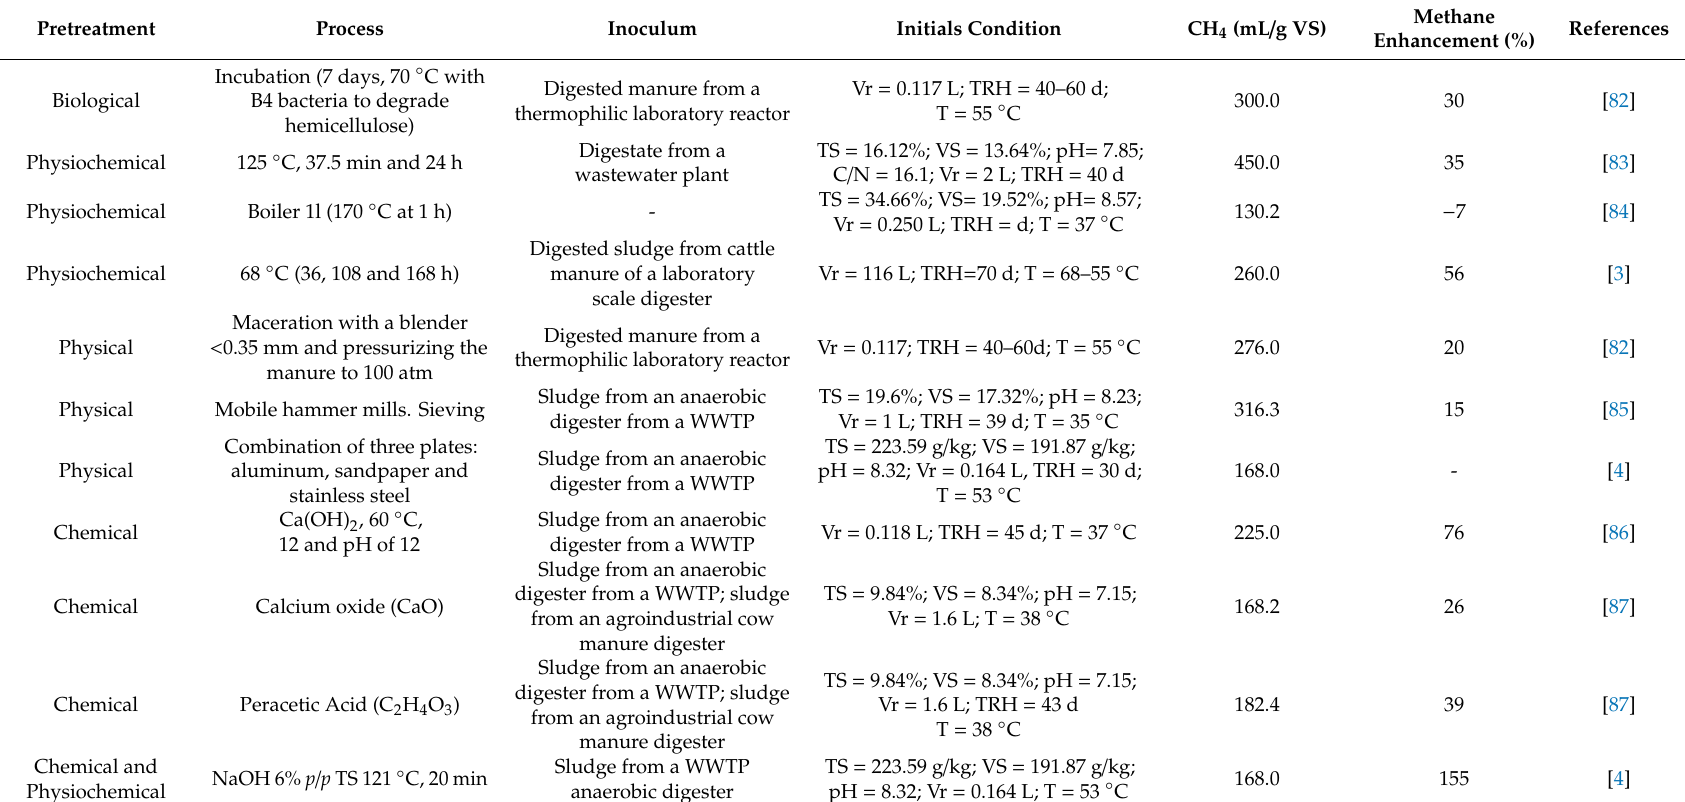
Table 3. E ff ects of the di ff erent pretreatments applied to cow